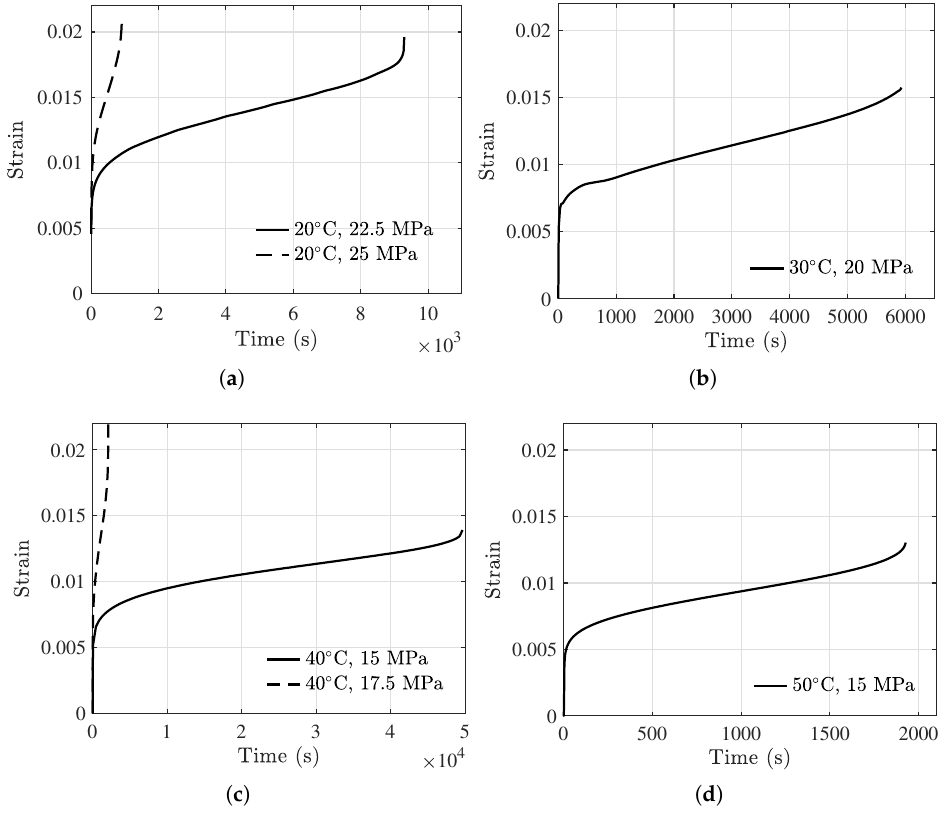
Figure 5. Creep testing results under different temperatures and stresses. ( a ) 20 ◦ C, ( b ) 30 ◦ C, ( c ) 40 ◦ C, and ( d ) 50 ◦